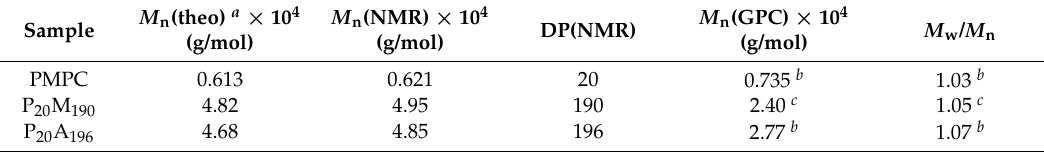
Table 1. Number-average molecular weight ( M n ), number-average degree of polymerization (DP), and molecular weight distribution ( M w / M n ) for the